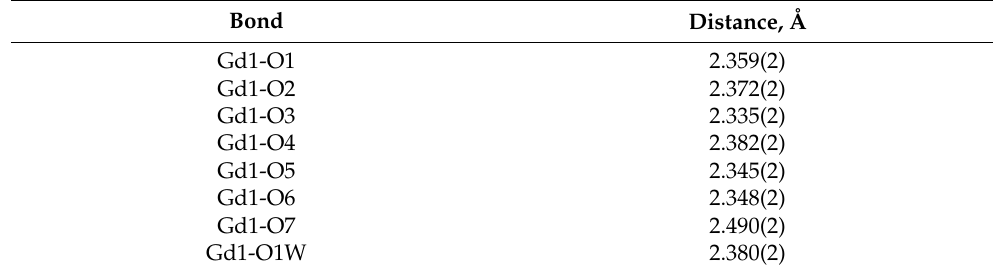
Table 2. Selected geometrical parameters for 2.